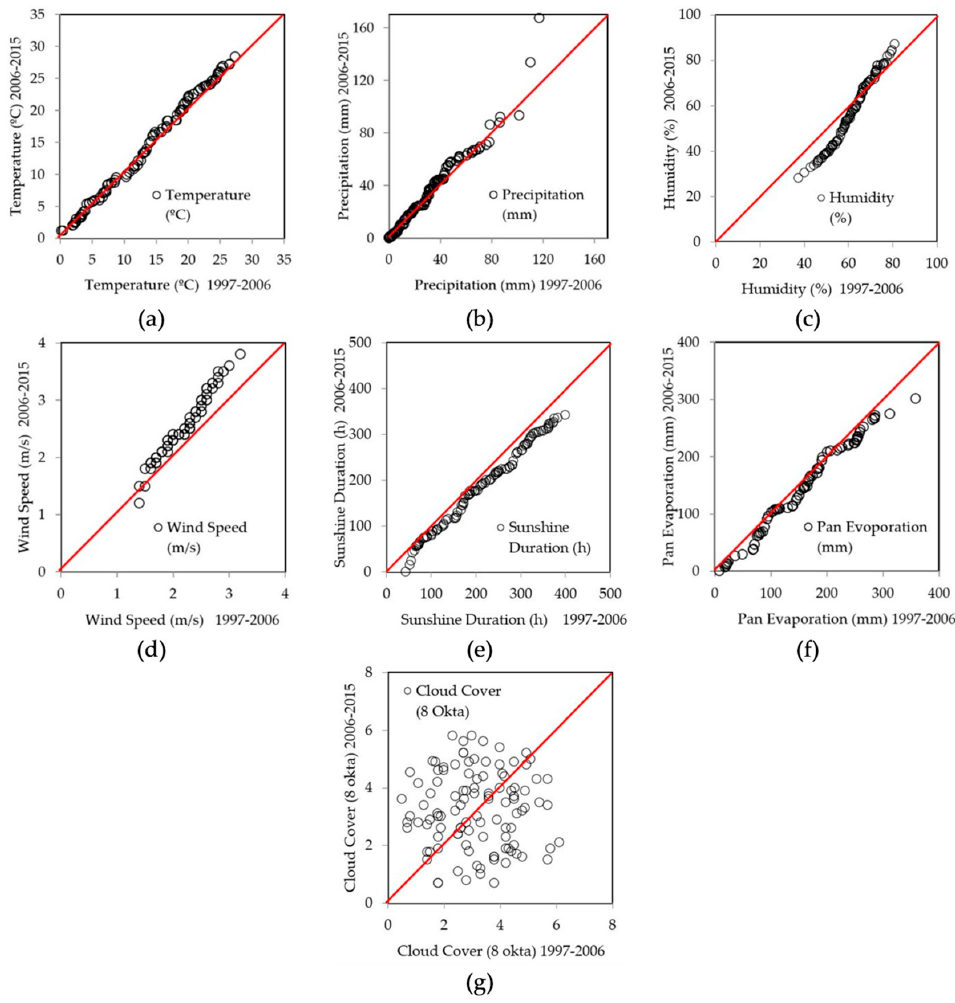
Figure 12. ST graphs of meteorological variables: ( a ) Temperature, ( b ) Precipitation, ( c ) Humidity, ( d ) Wind speed, ( e ) Sunshine duration, ( f ) Pan evaporation, ( g ) Cloud cover.